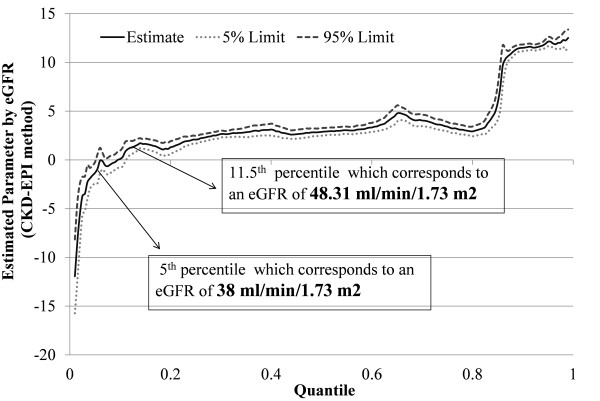
Quantile regression adjusted for comorbidities and age (fourth order polynomial) for CKD-EPI equation. The X axis displays eGFRs by quantiles (0-0.2 being the lowest 20% and 0.8- 1.0 being the highest 20%). The Y axis shows the difference in eGFR in ml/min in blacks compared to whites. For example, a black individual with an eGFR at the 40th percentile would have an eGFR approximately 3 ml/min higher than a white individual by CKD-EPI method. Using the MDRD equation, a black at the 40th percentile, would have an eGFR approximately 6 ml/min higher than a white individual.